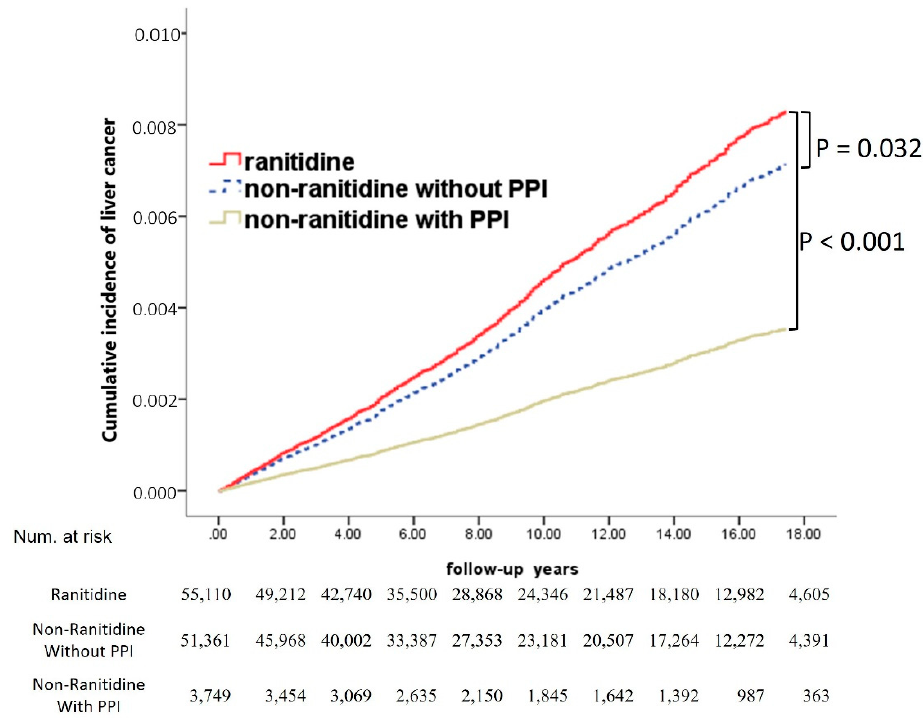
Figure 6. Cumulative incidences of liver cancer among ranitidine, non-ranitidine with PPI, and non-ranitidine without PPI users after adjustment for competing risks.